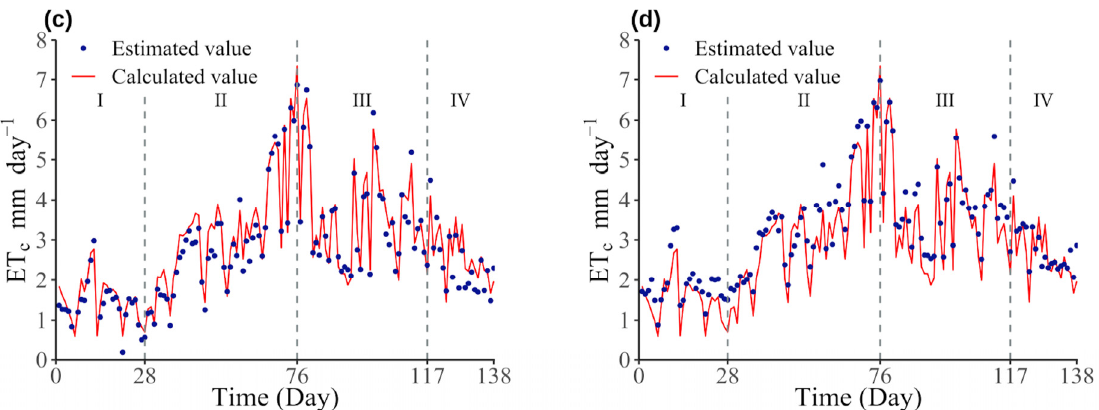
Figure 8. Comparison of simulated and calculated values of spring maize ET c in 2019 of different models with K c , T ave , T max , T min , n and RH as the input: RF–SVR–PSO model ( a ), SVR model ( b ), BPNN model ( c ) and RF model ( d ). The areas labeled I, II, III and IV indicate the initial stage, crop development stage, mid-season stage and late-season stage, respectively .